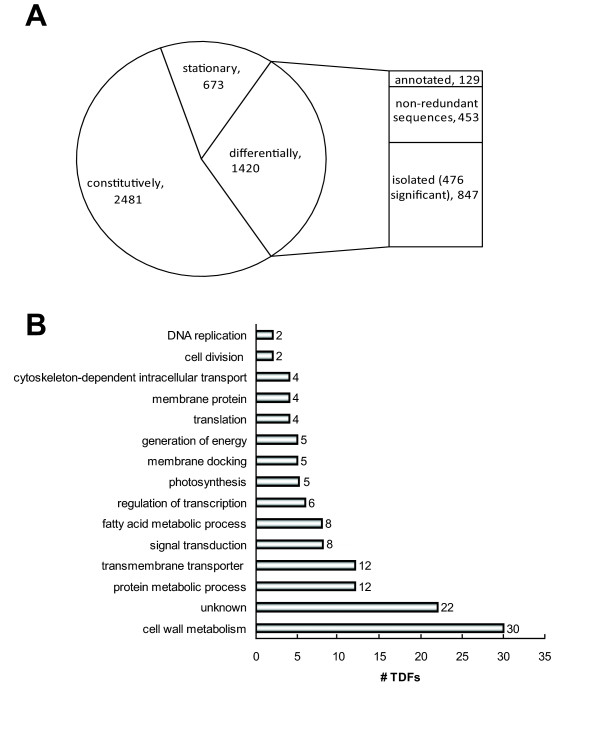
Transcript derived fragments (TDFs) identified by cDNA-AFLP analysis of Micrasterias denticulata cell growth. (A) In total, 4574 TDFs were scored, of which 2481 were constitutively expressed, 673 only in stationary cultures and 1420 displayed altered expression patterns across time (476 significantly; P < 0.009; Q < 0.05). Of the latter group, 847 were isolated from gel. From 453 non-redundant sequences, 129 could be annotated. (B) Functional classification of the 129 annotated transcript-derived fragments (TDFs) differentially modulated during cell growth.